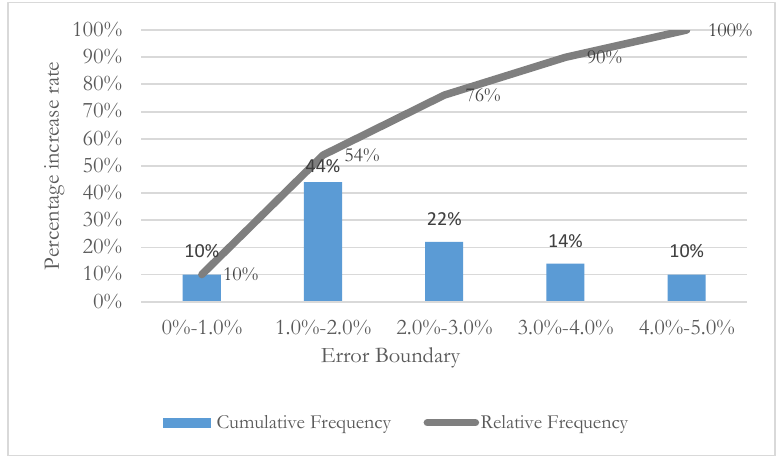
Fig. 3. Reviewed upper bounds of solution errors for the relaxation of the first constraint